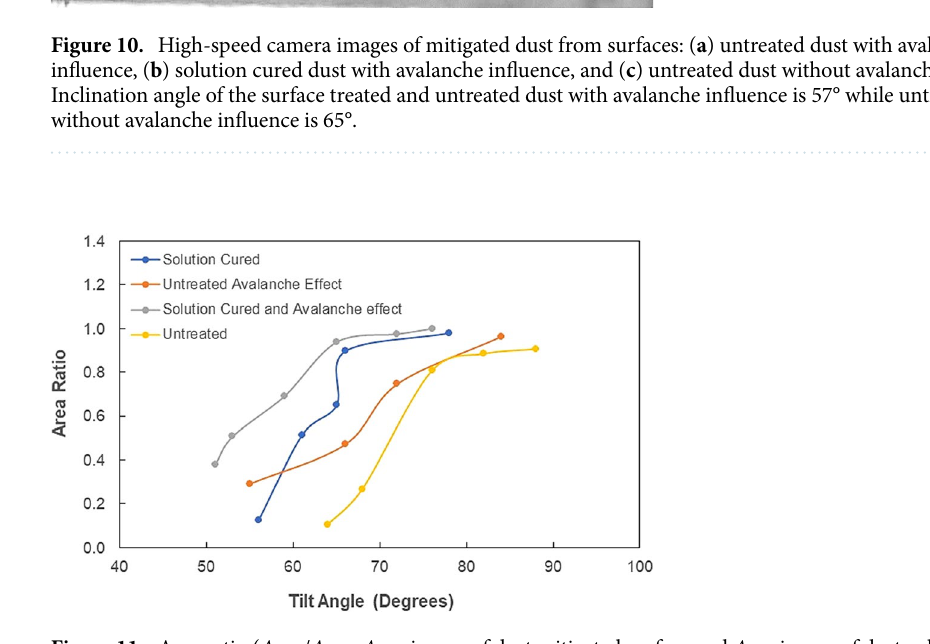
Figure 11. Area ratio ( A clean / A Total , A clean is area of dust mitigated surface and A Total is area of dusty glass surface) with glass surface tilting angle for solution cured and untreated dusts with and without avalanche